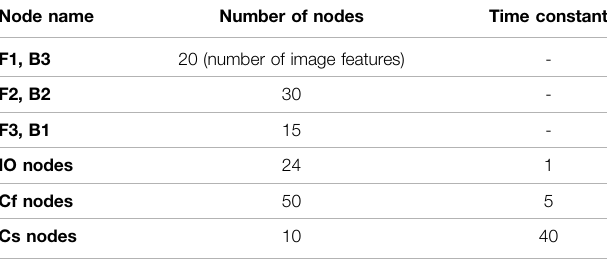
TABLE 2 | The structure of the MTRNN attaching fully connected layers. MTRNN contains three node types with different time constants: input – output (IO) nodes, fast context (Cf) nodes, and slow context (Cs) nodes. Since image data contain more complex and varied information than do other data, we connect